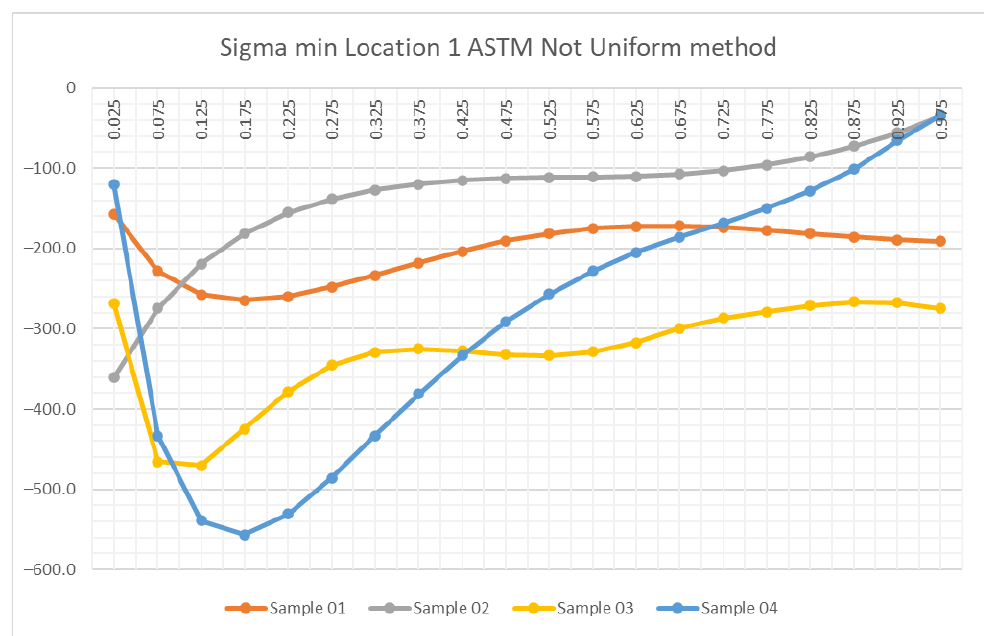
Figure 6. The resulting values of residual stresses (Sigma min) for all four samples at the measuring Location 1.